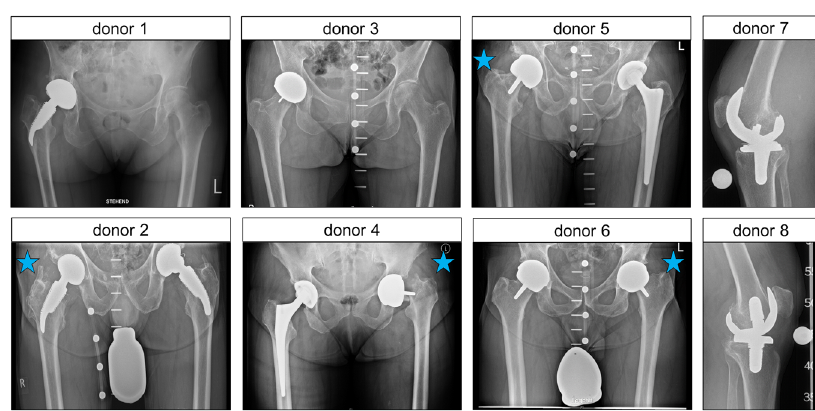
Fig. 1 Radiographs taken